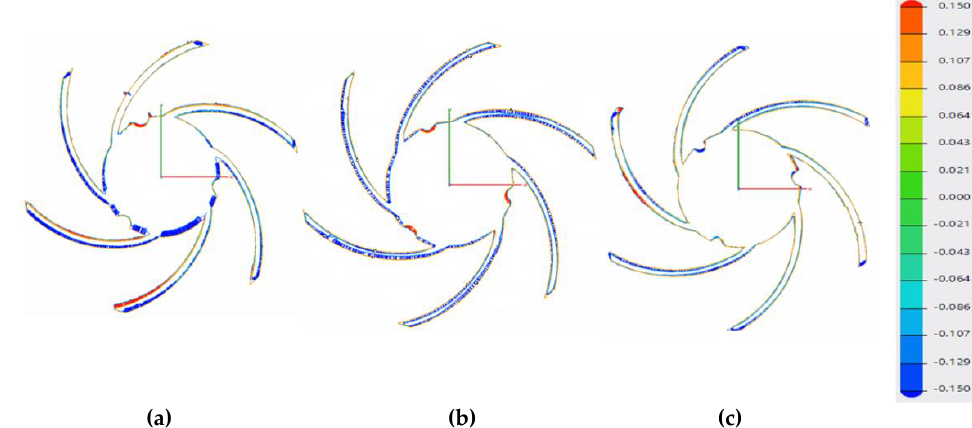
Figure 13. Blade thickness evaluation using 3D measurements for: ( a ) as-printed impeller (before AFM), (b) Impeller 1, and (c) Impeller 2.